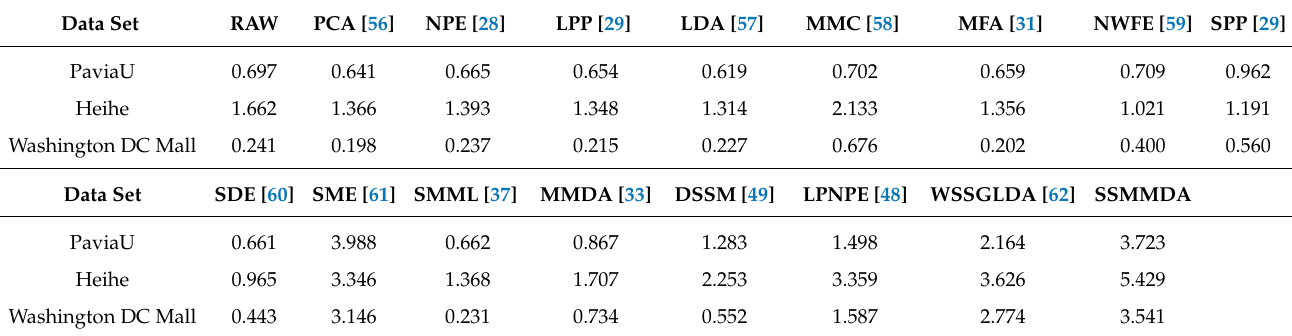
Table 7. Computational time (in seconds) of different algorithms on PaviaU, Heihe and Washington DC Mall data